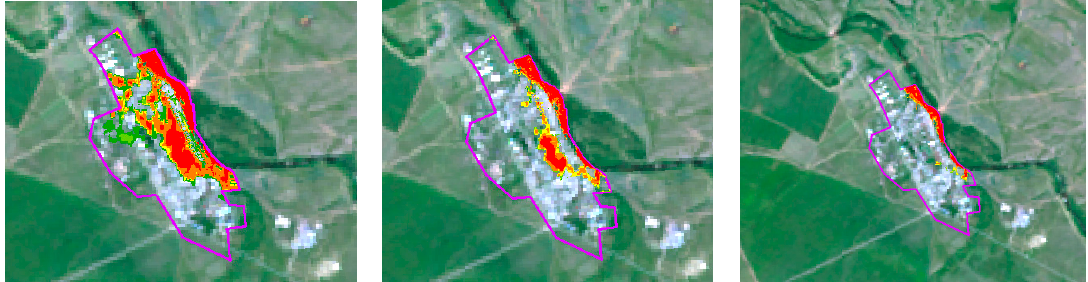
Figure 13. Flood hazard maps generated for the territory of the village Arnasay for different flood